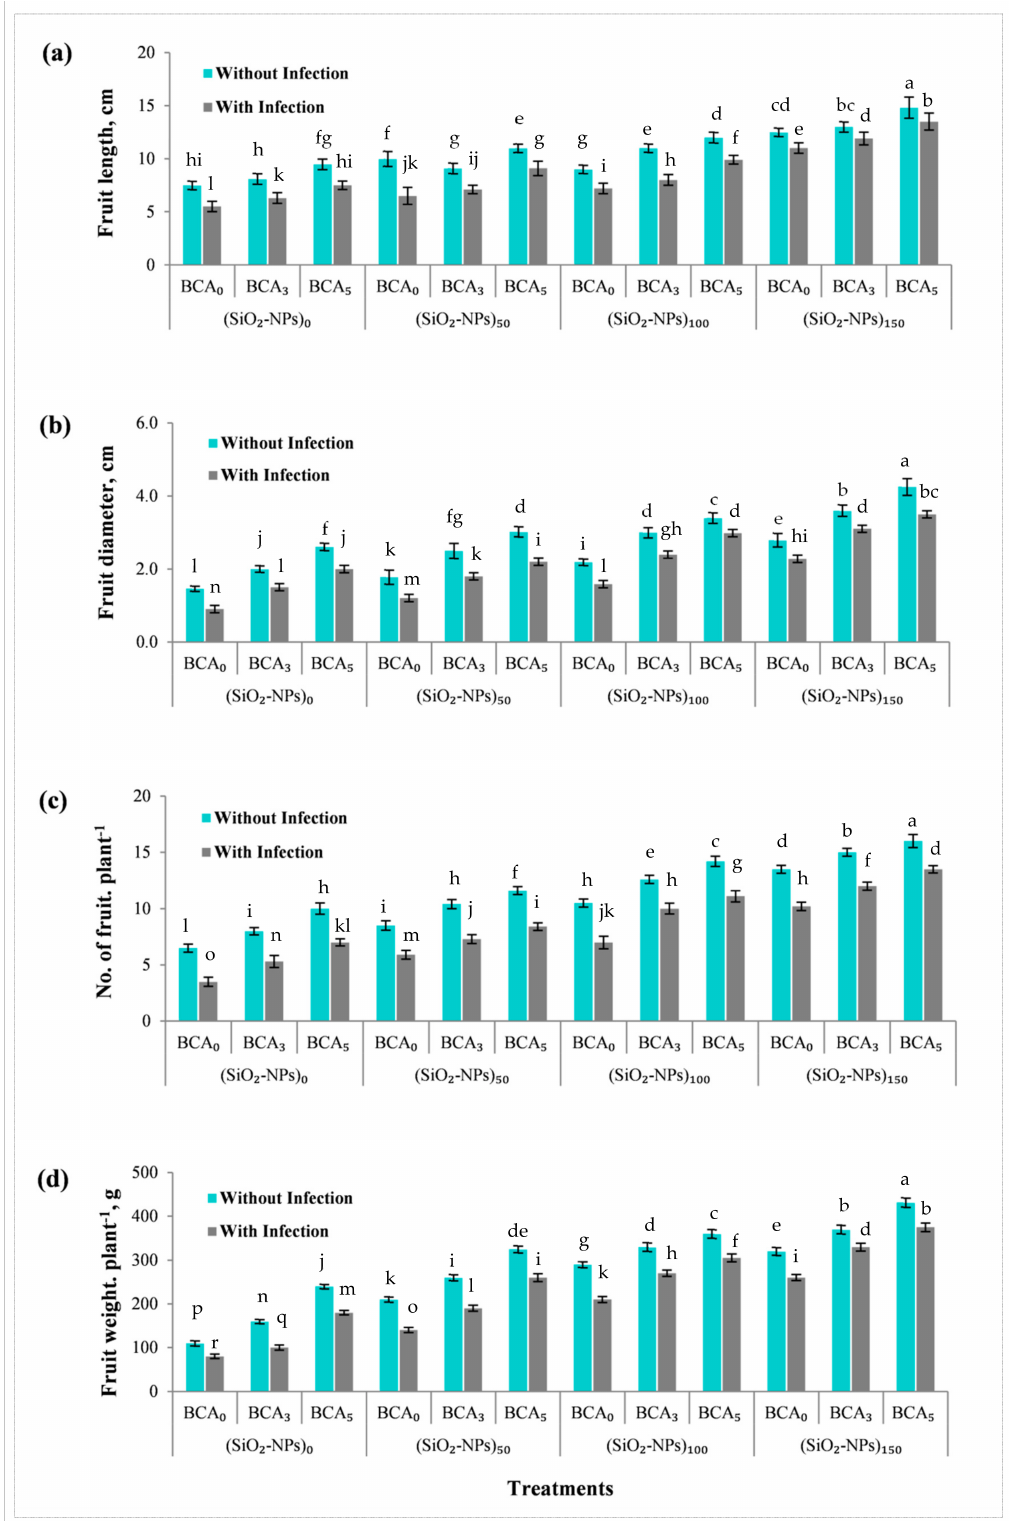
Figure 7. Pepper fruit yield and quality parameters at harvesting time, as affected by different treatments of SiO 2 -NPs (ppm), and BCA (%) without and with bacterial infection. ( a ) fruit length, ( b ) fruit diameter, ( c ) fruit number per plant, and ( d ) fruit weight per plant. Error bars represent the mean ± SD of the data of 5 replications. Different letter(s) above the error bars indicate statistically significant differences at ( p ≤